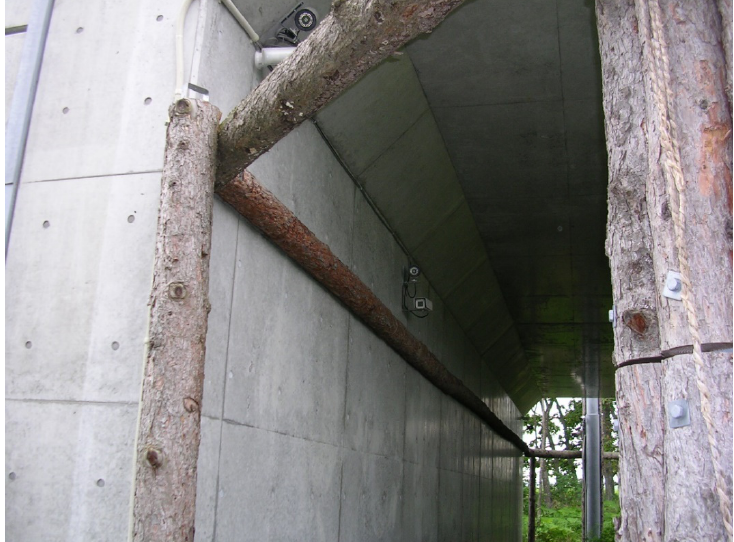
Figure 1. Example of a log bridge used by the Siberian Flying Squirrel ( Pteromys volans ) in Japan. The photograph shows a log bridge running through a culvert under a road for crossing. Photo captured and provided by Dr. Yushin Asari from Obihiro University of Agriculture and Veterinary Medicine.